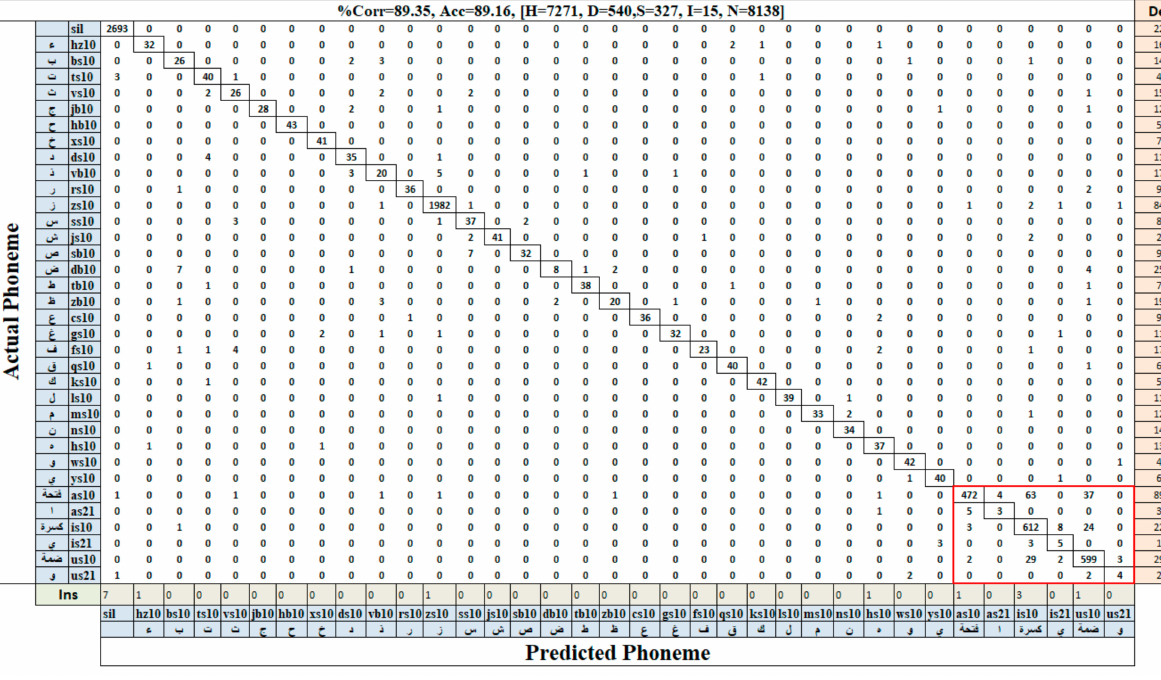
Figure 11. Confusion matrix of the detected Arabic phonemes from matching AF vectors using the AFD-Obj (YOLOv3-tiny- 1S) model at 100%